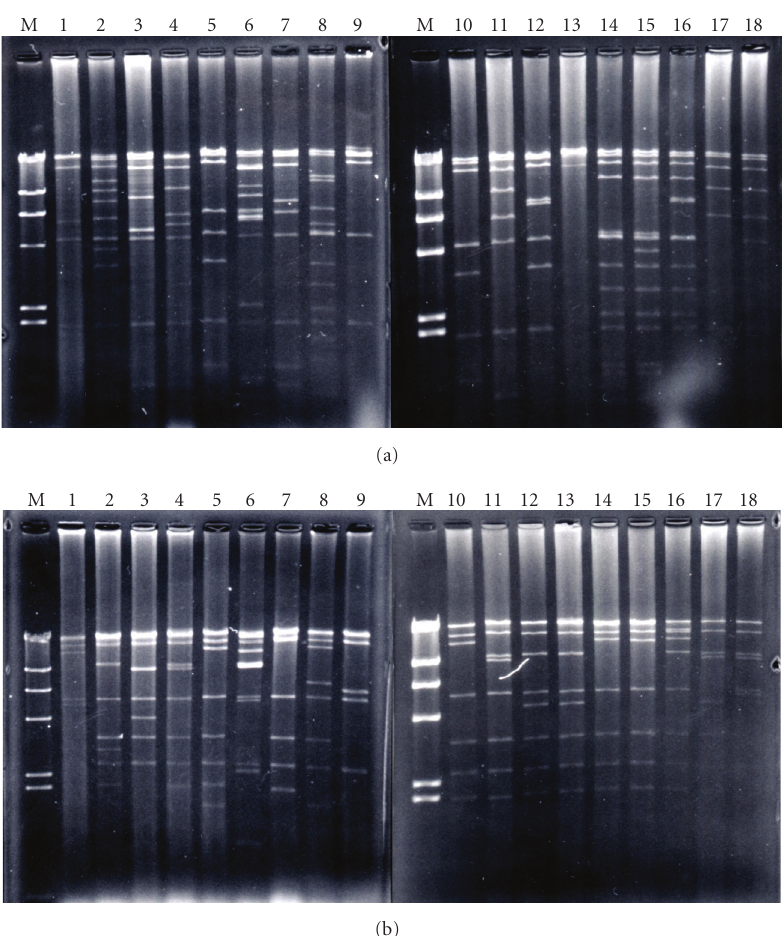
Figure 1: Eco RI (a) and Eco T22I (b) restriction fragments of the plasmid types of R. equi isolates of intermediate virulence. Lanes 1, strain A2 (plasmid type 1); lanes 2, strain S2 (plasmid type 2); lanes 3, strain S3 (plasmid type 3); lanes 4, strain S4 (plasmid type 4); lanes 5, strain A5 (plasmid type 5); lanes 6, strain S6 (plasmid type 6); lanes 7, strain S7 (plasmid type 7); lanes 8, strain S8 (plasmid type 8); lanes 9, strain S9 (plasmid type 9); lanes 10, strain A11 (plasmid type 10); lanes 11, strain A43 (plasmid type 11); lanes 12, strain 70 (plasmid type 12); lanes 13, strain H3 (plasmid type 13); lanes 14, strain H25 (plasmid type 14); lanes 15, strain H43 (plasmid type 15); lanes 16, strain H66 (plasmid type 16); lanes 17, strain 316 (plasmid type 17); lanes 18, new strain (plasmid type 18). The markers (lanes M) are Hind III digestion products of bacteriophage λ